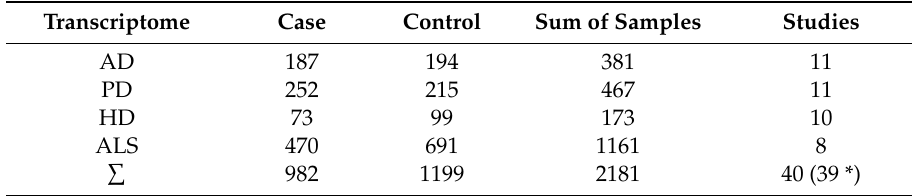
Table 1. Overview of the number of cases and controls and the total number of studies per disease throughout all analyzed transcriptome studies. In total, data of 2181. Samples were gathered from 39 studies analyzing transcriptomic data. * One study conducted experiments for AD and HD. Thus, in total proteomic data of 22 studies was